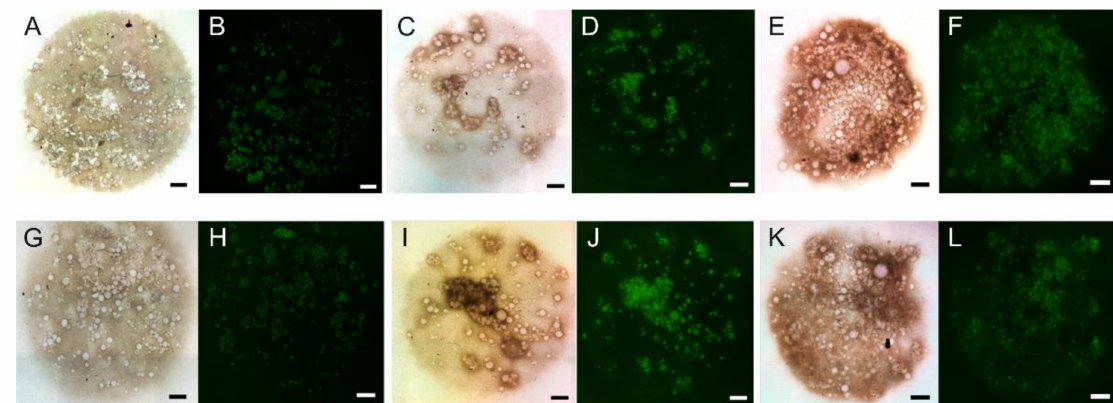
Figure 4. Brightfield and fluorescence microscopy images of micromasses of human periosteum-derived cells (hPDCs) combined with genipin crosslinked gelatin microspheres, which appear as fluorescent green spheres, with or without transforming growth factor (TGF)- β 1. ( A – F ) After 2 weeks of in vitro culture. ( G – L ) After 4 weeks of in vitro culture. Scale bars are 500 µ m. Reproduced with permission from [85]. © 2021